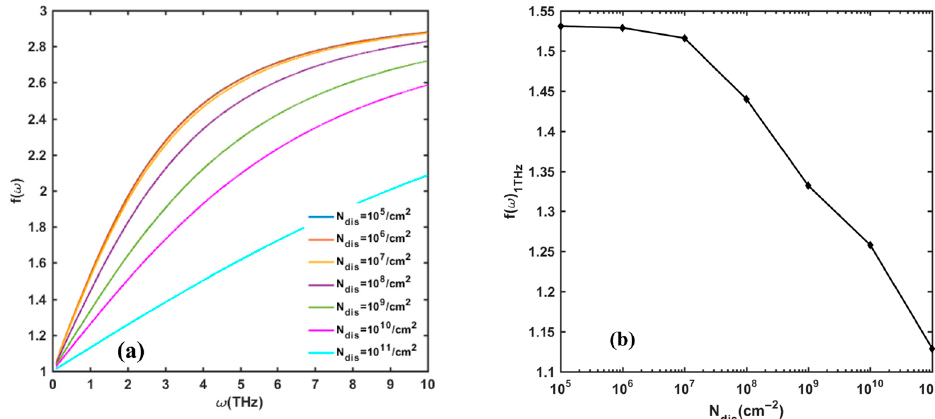
Figure 7. ( a ) The variation in f ( ω ) with dislocation density N dis in frequency range of 0.1–10 THz. ( b ) Value of f ( ω ) at 1 THz incident frequency with change in N dis . Other parameters are taken as n s = 10 13 /cm 2 , ∆ = 1 nm, and Λ = 10 nm.